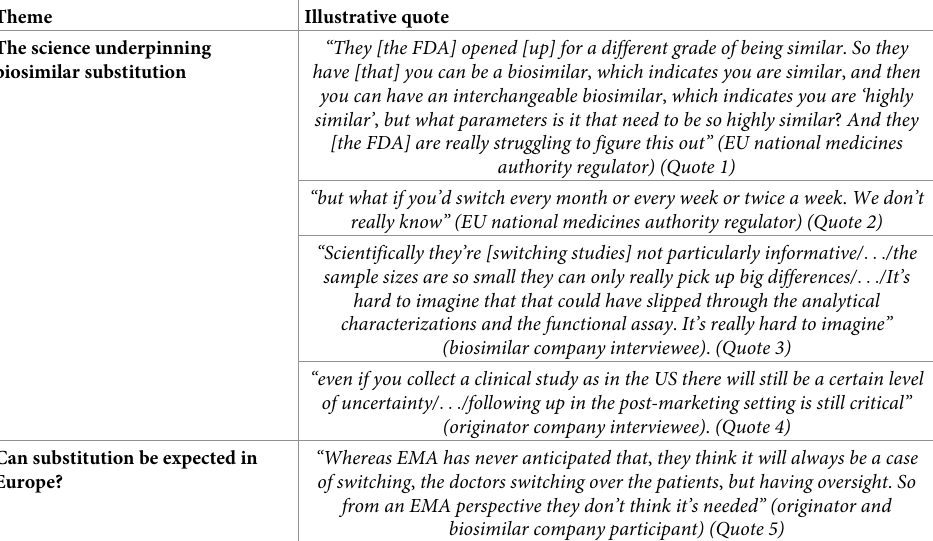
Table 3. Selected quotes from interviewees on interchangeability of